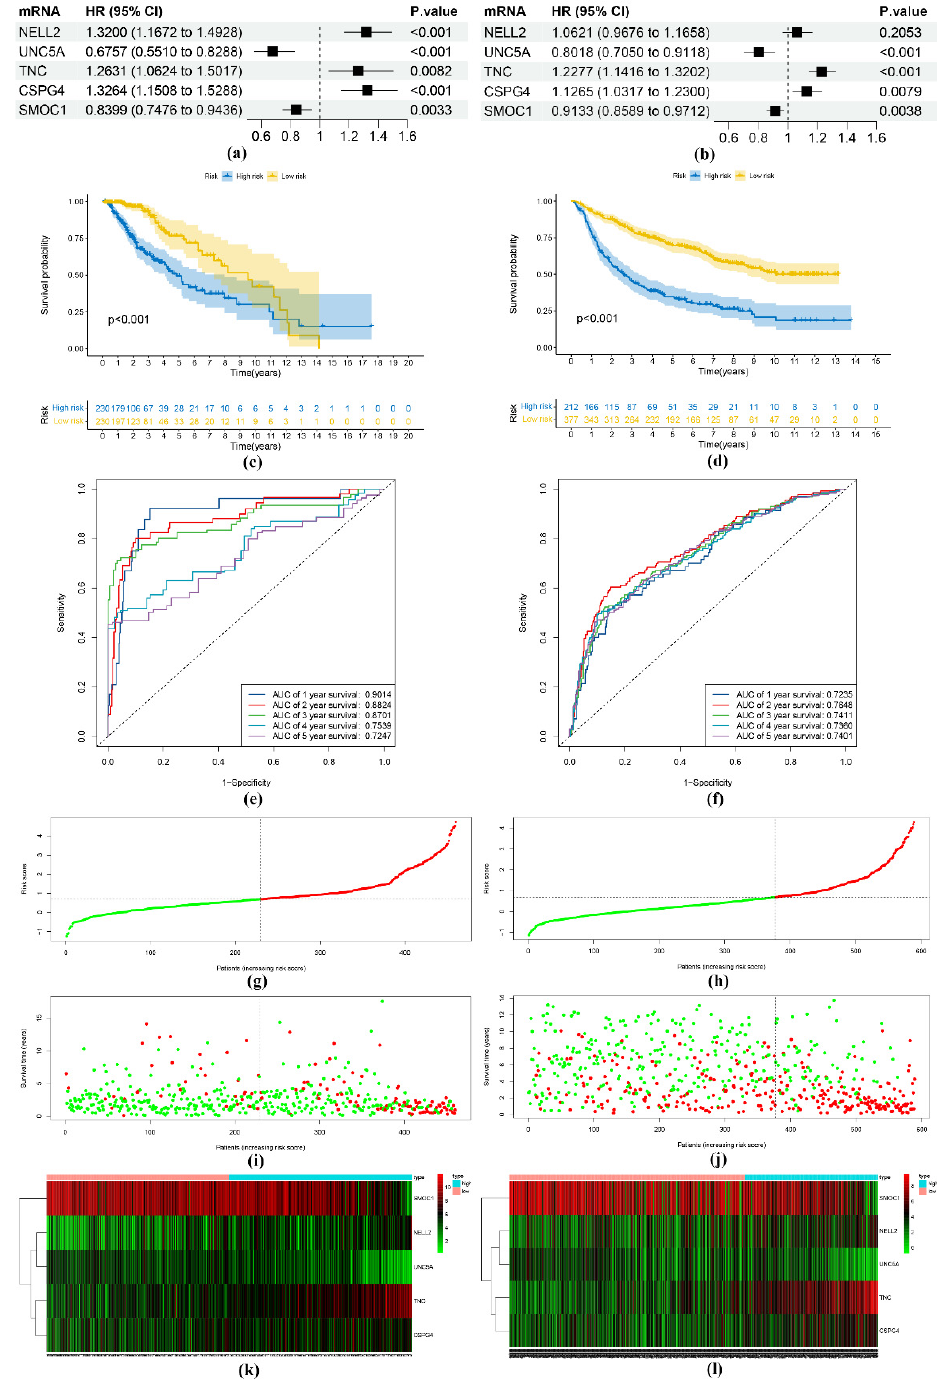
Figure 3. Establishment and verification of a risk score model. HR values of risk-score-model-related genes in the TCGA ( a ) and CGGA cohorts ( b ). Survival analysis of the risk score in the TCGA ( c ) and CGGA cohorts ( d ). ROC curves for 1-, 2-, 3-, 4-, and 5-year risk scores in the TCGA ( e ) and CGGA cohorts ( f ). Distribution of risk scores ( g , h ), patients’ survival ( i , j ), and heatmap of 5 BM-related genes ( k , l ) in the TCGA and CGGA cohorts, respectively. The green dots in the figures indicate survival, and the red dots indicate death.